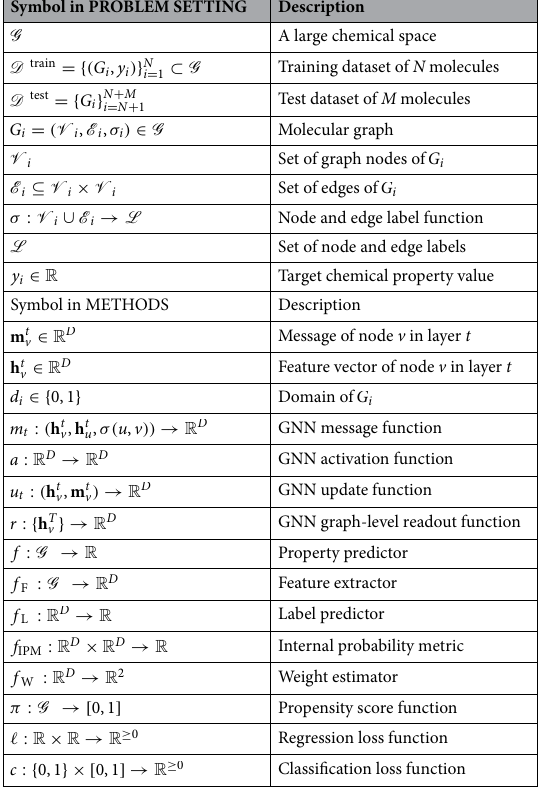
Table 1. List of symbols used in this